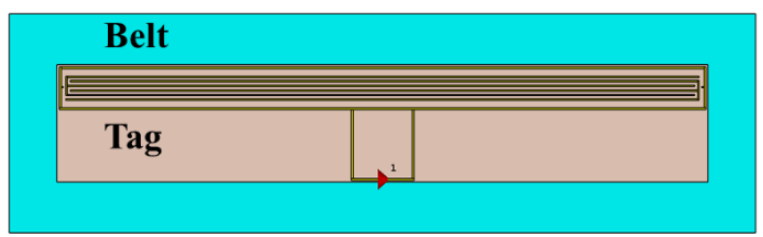
Figure 6. Tag placed on top of the belt.